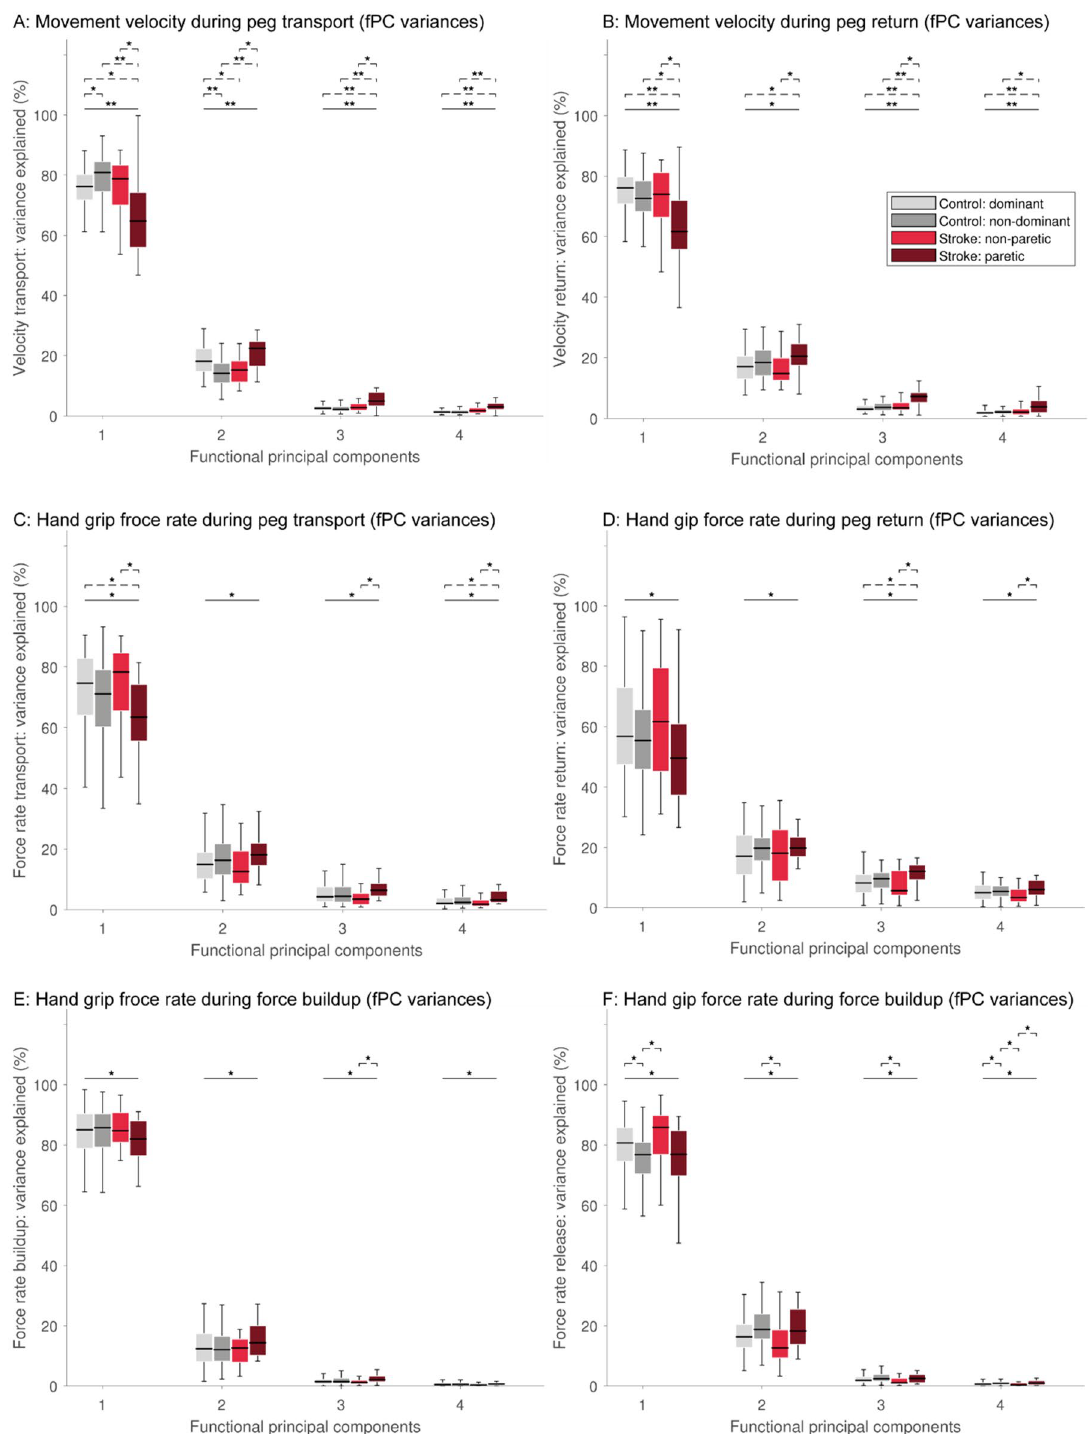
Figure 5. Population-level comparison of variance explained per fPC, task phase, and modality. Horizontal solid line indicates results from an omnibus test and dashed lines from post-hoc tests. *Indicates P < 0.05, ** P <